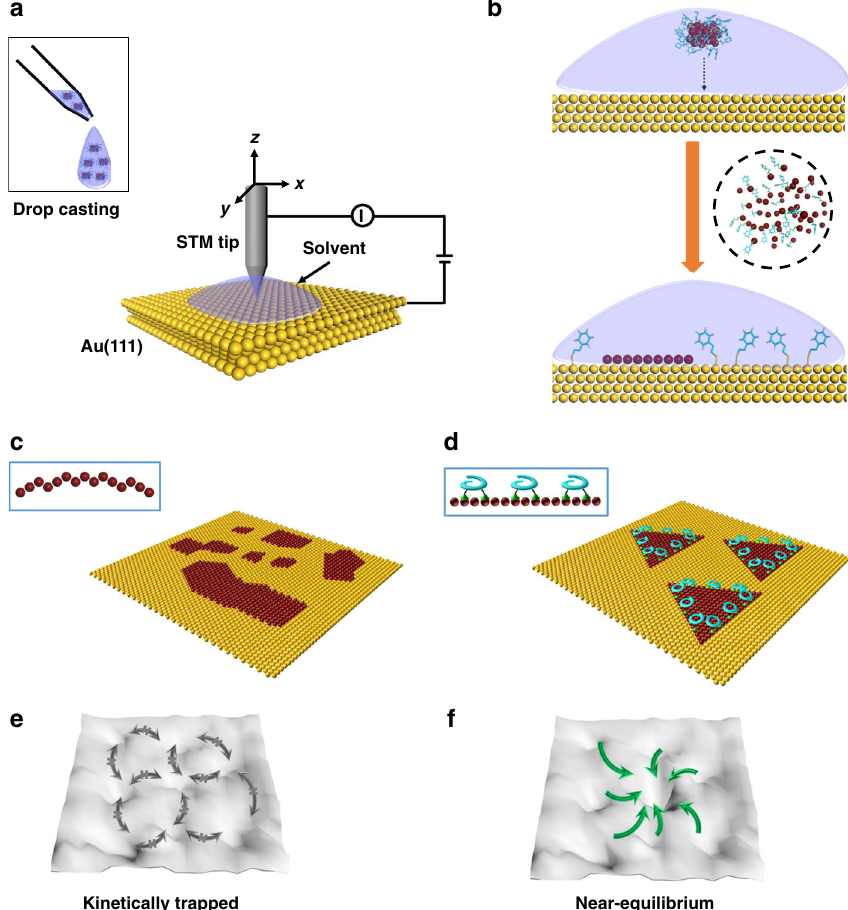
Fig. 1 Atomic layer deposition at the liquid-metal interface. a Schematic illustration of STM measurement at the liquid-Au(111) interface. Solutions of different compounds are transferred to surface via dropcasting. b Growth of Au nanoislands via a wet deposition protocol. The atomic layer growth starts with the decomposition of thiolate-protected gold clusters at the solution-metal interface. Au atoms of the cluster and the island appear brown. c , d Growth of Au nanoislands in the absence ( c ) and presence ( d ) of surface-active helicenes (the blue ‘ helix ’ presentations) in solution. e , f Potential energy surfaces showing the growth kinetics of islands. The depth of the wells represents the relative stability of the islands, whereas the grey and green arrows indicate the pathways that are infeasible and feasible, respectively. Without organic modi fi ers, adatoms which are trapped at metastable binding sites cannot spontaneously switch to the optimum binding sites, giving rise to the formation of complex irregular metastable nanoislands. The adsorption and organization of helicenes at the step edges of the islands, on the other hand, impart a signi fi cant bias to the island growth along given directions, leading